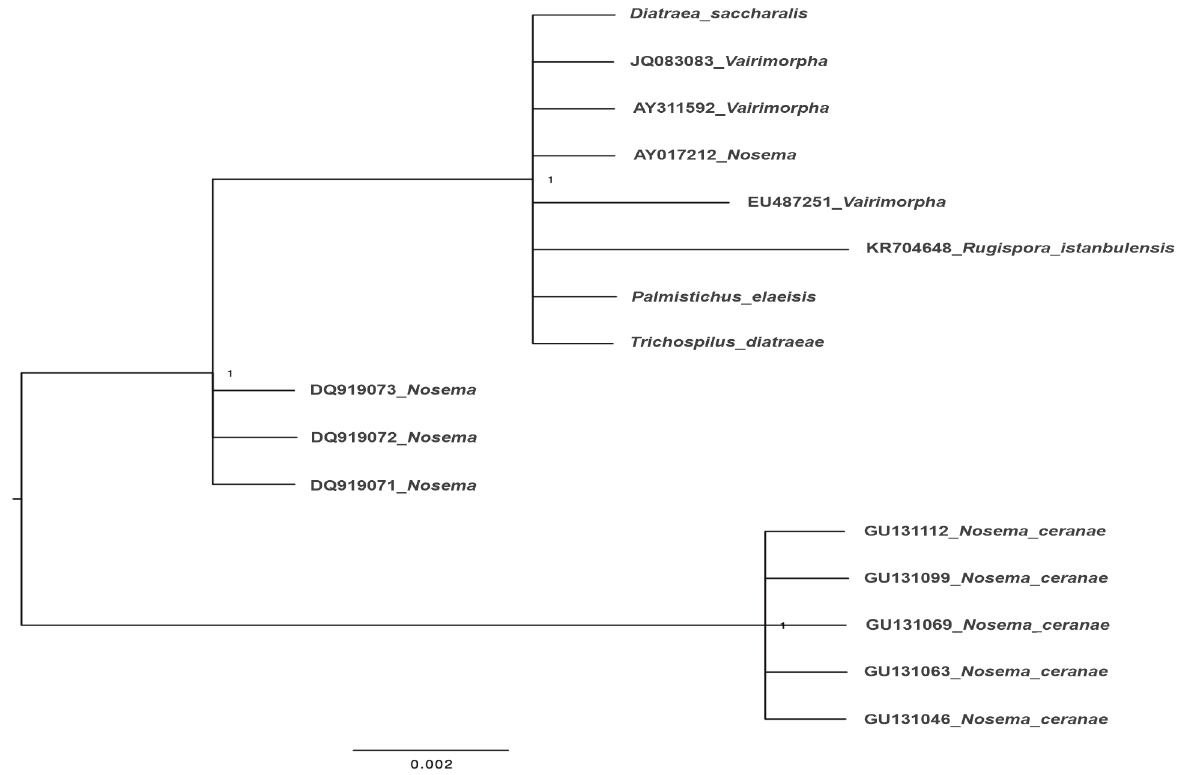
Figure 2 - Phylogenetic tree of the small subunit region (SSU) of ribosomal rNA from microsporidia isolated from D. saccharalis and from the parasitoid T. diatraeae and P.